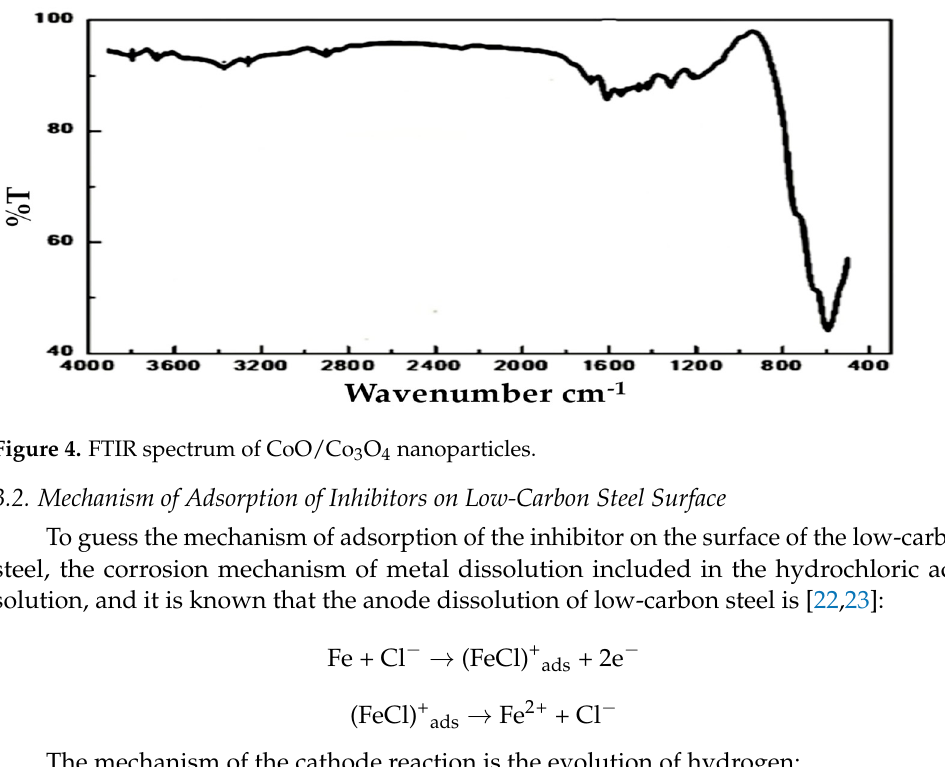
Figure 4. FTIR spectrum of CoO/Co 3 O 4 nanoparticles.